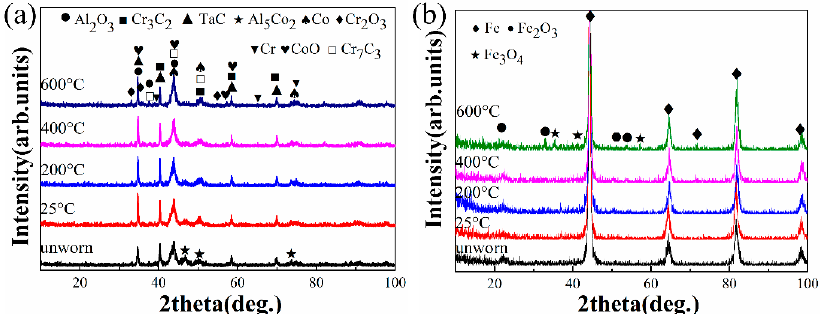
Figure 7. The unworn and worn surface at different temperatures: ( a ) CoCrAlYTa-10%Al 2 O 3 coating; ( b ) H13 steel.